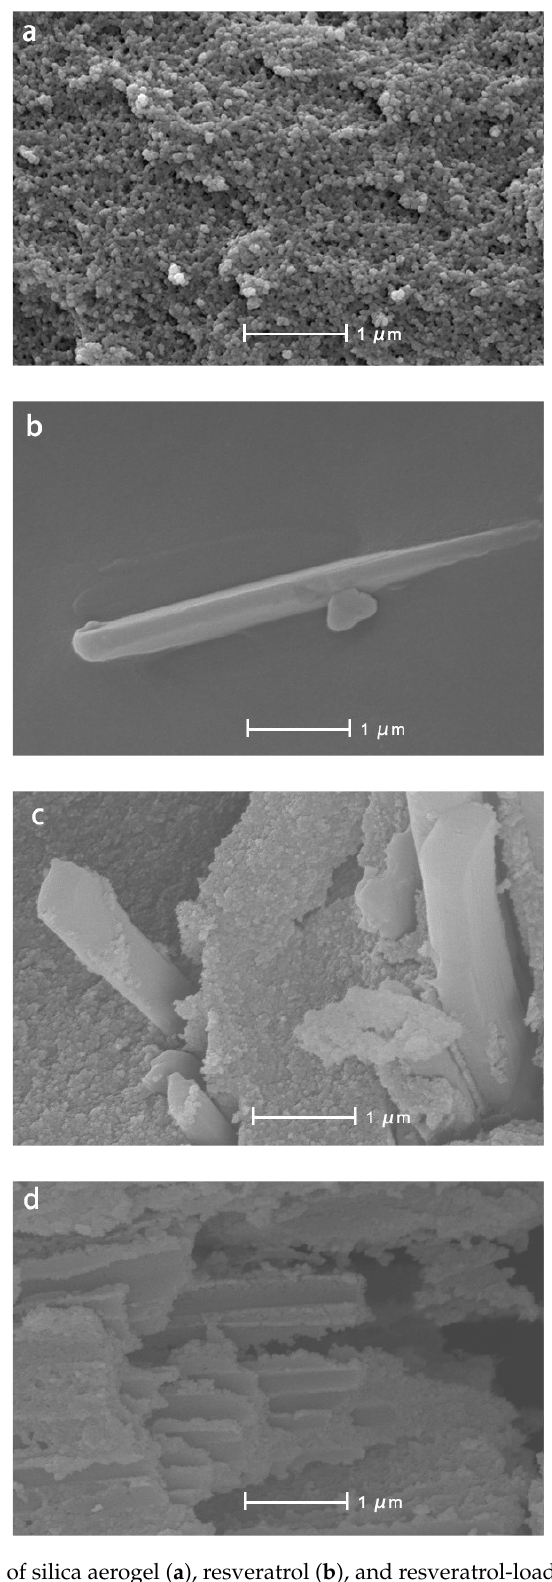
Figure 2. SEM images of silica aerogel ( a ), resveratrol ( b ), and resveratrol-loaded silica aerogel ( c , d ). The FTIR spectra of resveratrol, silica aerogel, and RSA are represented in Figure 3. The FTIR spectrum of resveratrol showed the presence of the following main peaks. The peak near 3200 cm assigned to the free O–H stretching vibration. A double peak at 1600 cm